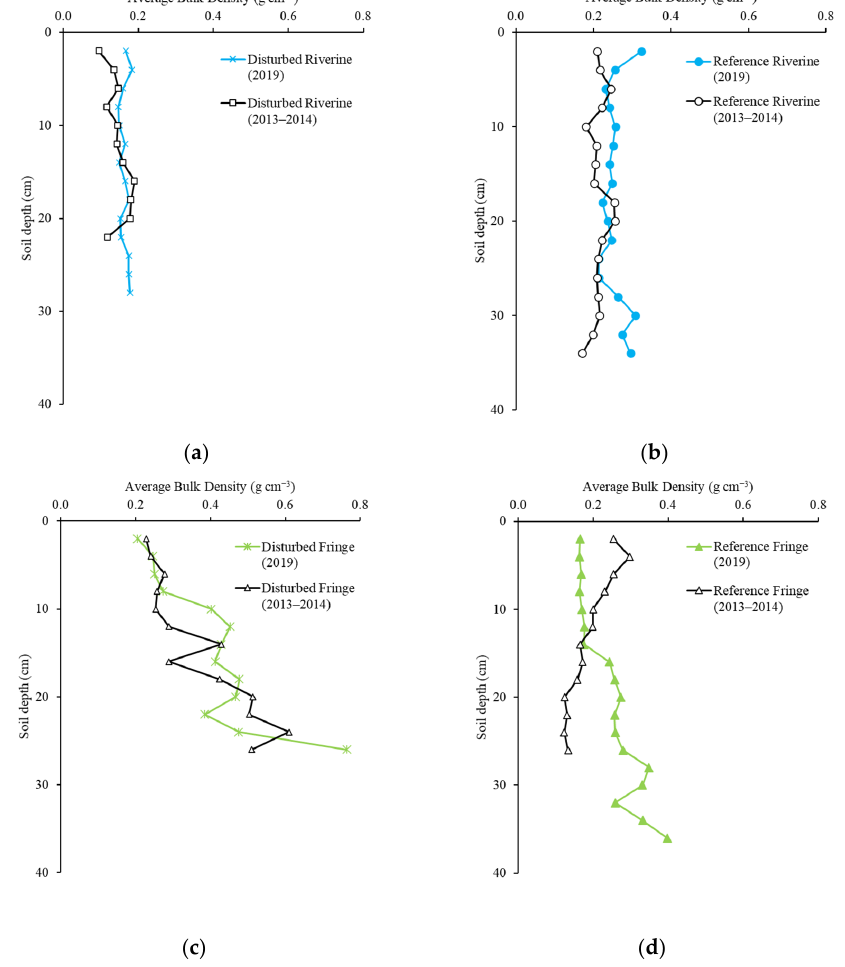
Figure 2. Average bulk density of soil in the period 2013–2014 and 2019 at each 2 cm of depth in ( a ) the disturbed riverine site; ( b ) the reference riverine site; ( c ) the disturbed fringe site; and ( d ) the reference riverine site.